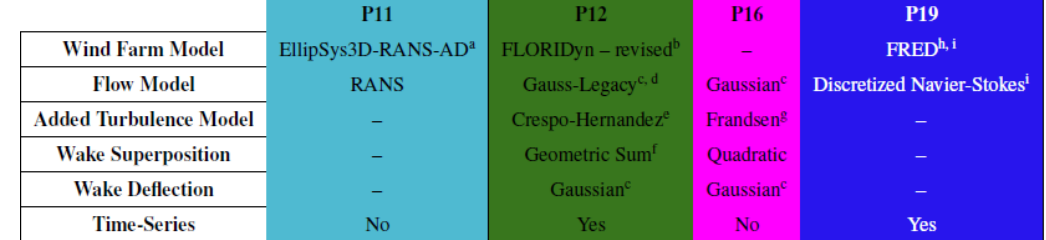
Table 8. Overview of the participating WFFC-oriented models, CL-Windcon LES blind test. a Sørensen (1995). b Becker et al. (2022a) and Becker et al. (2022b). c Bastankhah and Porté-Agel (2016). d Bastankhah and Porté-Agel (2014). e Crespo and Hernández (1996). f